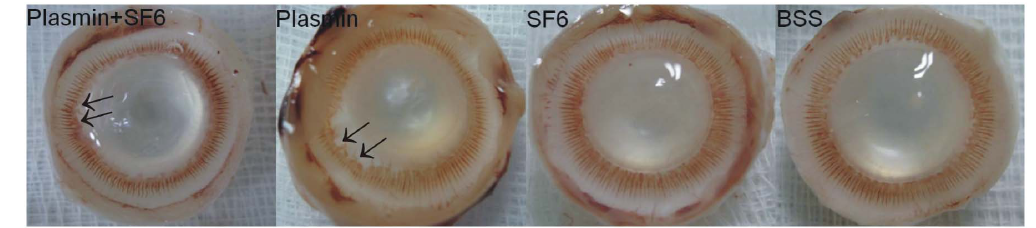
Figure 4. Ciliary process disruption after plasmin treatment. Ciliary process disruption after intravitreal injections of plasmin. Viewed from the back of the eye, partial ciliary body disruption was noted in the eyes treated with plasmin and SF 6 (plasmin + SF 6 group) or plasmin alone (plasmin group) (black arrows). The eyes treated with SF 6 (SF 6 group) or BSS (BSS group) showed no signs of ciliary process disruption.